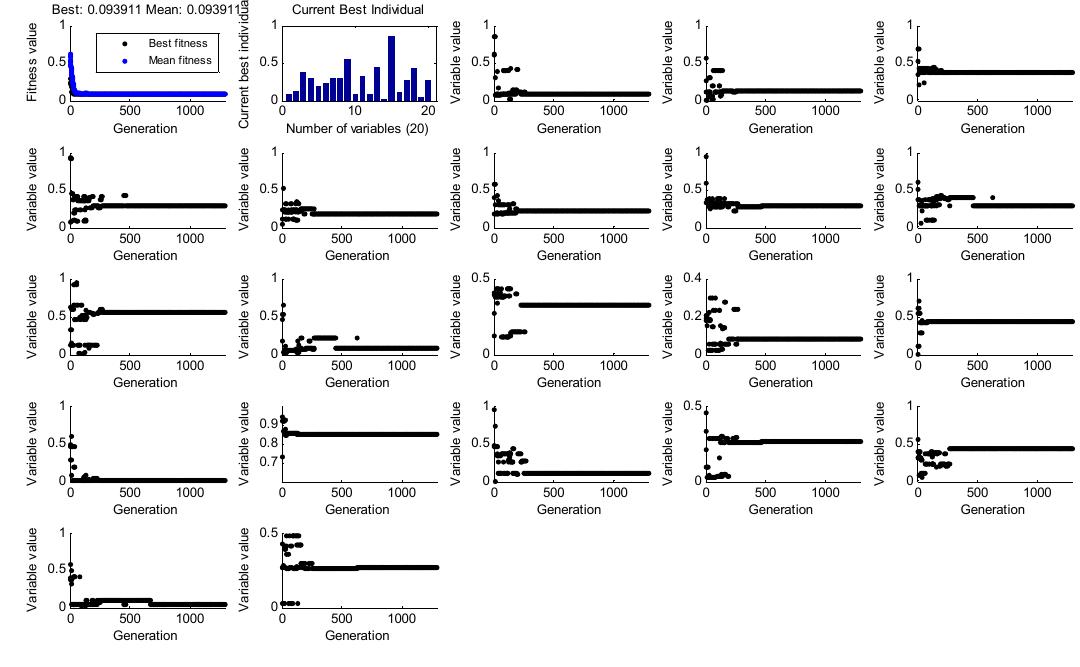
Figure 6. Running process of GA.